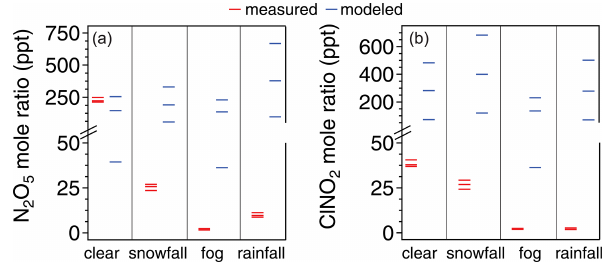
Figure 6. A comparison of measured (red) vs. modeled (blue) mole ratios of N 2 O 5 (a) and ClNO 2 (b) for each case study night. For measured values, the minimum, average, and maximum mole ra- tios from 04:00–08:00EST of each case study (Fig. 3) are shown. For modeled values, the average mole ratios from the last 4h of each 14h simulation are shown; model inputs for the case stud- ies are described in Sect. S1. Here, we hold the γ × ϕ product (N 2 O 5 uptake × ClNO 2 yield) constant at 0.0037, and we show the model outputs when [NO 2 ] = 9.4, 31, and 59ppb, respectively; [NO 2 ] = 9.4ppb produced the lowest modeled values of N 2 O 5 and ClNO 2 , and [NO 2 ] = 59ppb produced the highest modeled values of N 2 O 5 and ClNO 2 . For context, McNamara et al. (2020) previ- ously reported a modeled median [NO 2 ] of 31ppb and γ × ϕ prod- uct constant of 0.0037 for wintertime Ann Arbor,